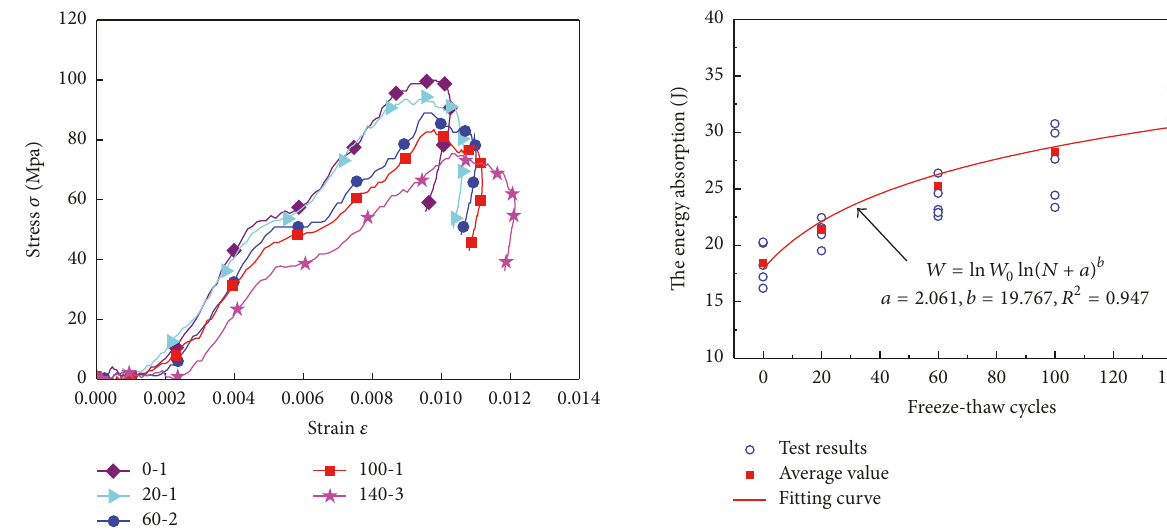
Figure 7: The dynamic stress-strain curves of sandstone under different freeze-thaw cycles.